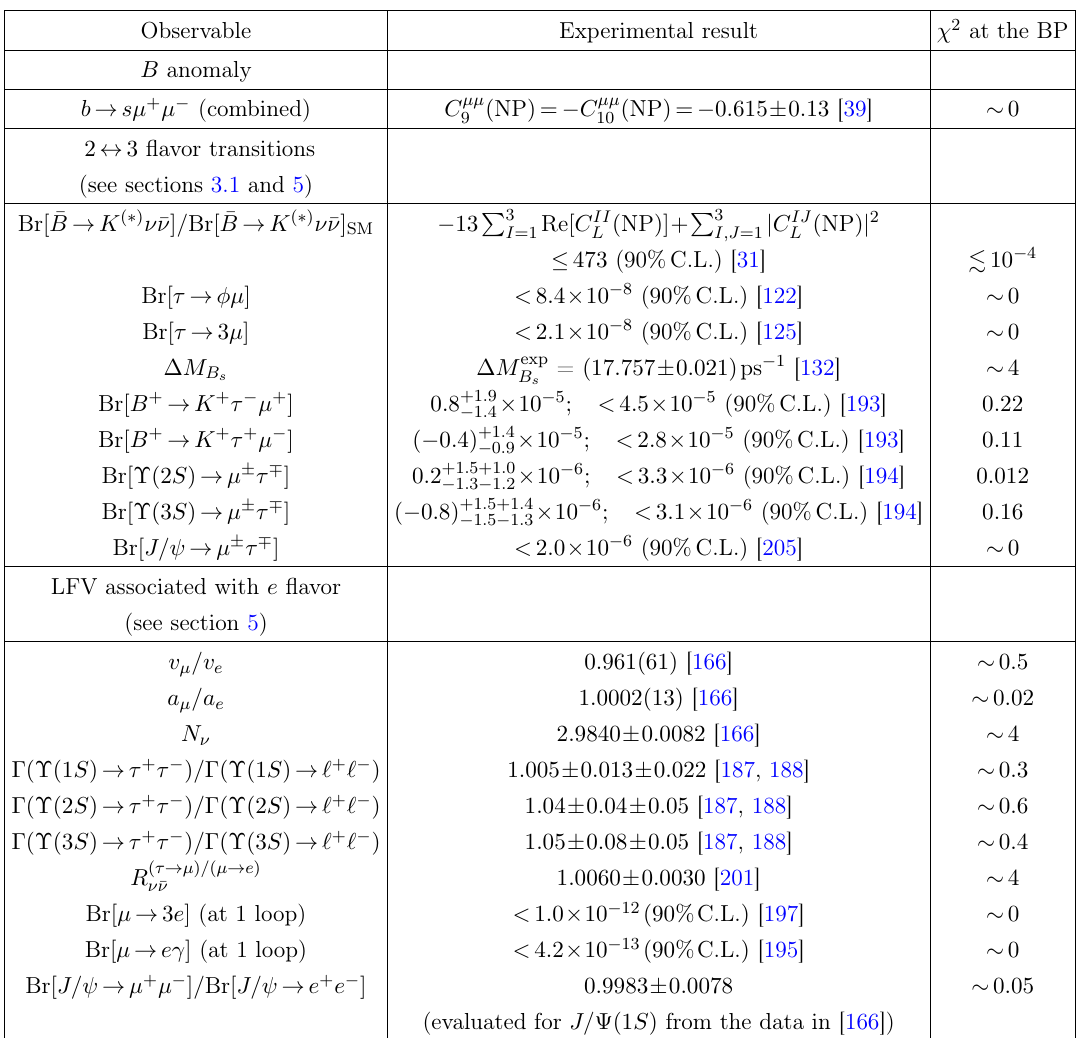
Table 1 . List of observables used for our (cid:31) 2 calculation and individual (cid:31) 2 values at the